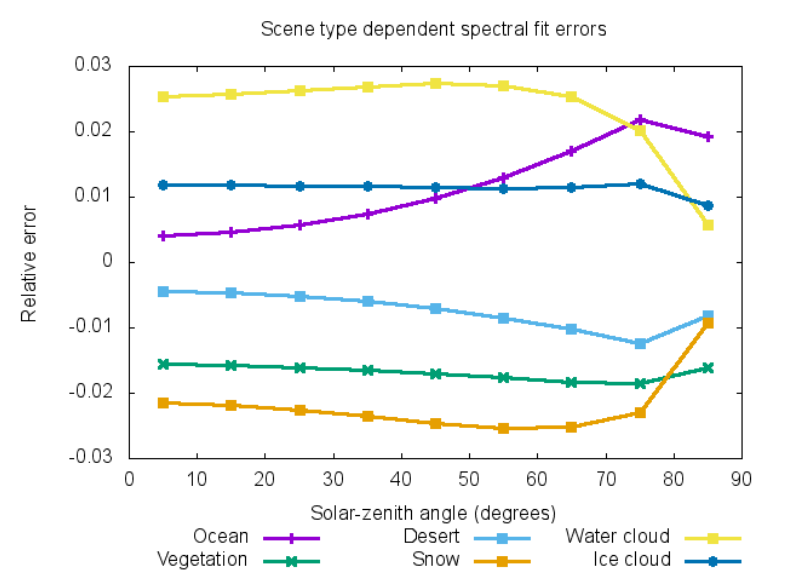
Figure 9. Scene-type dependent regression error on the broadband albedo as a function of the solar-zenith angle. The relative error on the estimate of the broadband albedo is lower than